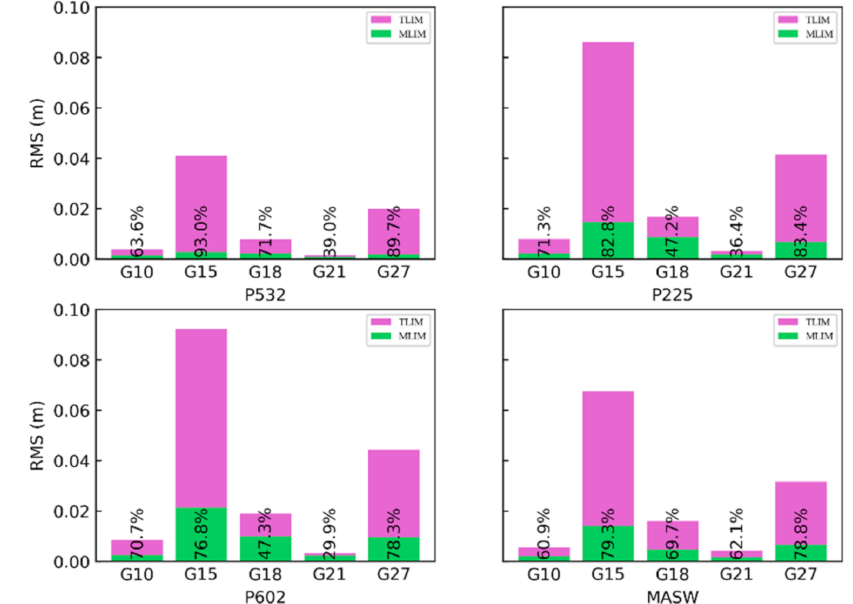
Figure 14. RMS errors of the DD tropospheric delay using modified and traditional methods for all non-reference satellites at all rover stations. The percentages on each bar are the improvements of the MILM with respect to the TLIM.